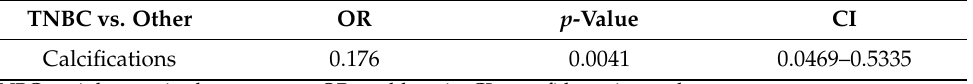
Table 9. Effect of lack of calcifications in TNBC breast cancer versus other breast cancer